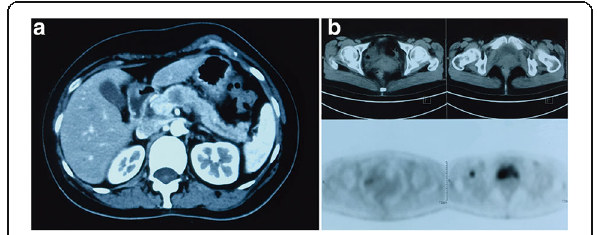
Fig. 1 a : Contrast-enhanced computed tomography scan of the abdomen showing a low-density mass confined to the neck of pancreas. b : Positron emission tomography/computed tomography scan of the pelvis: a lytic bony lesion in the right caput femoris, with